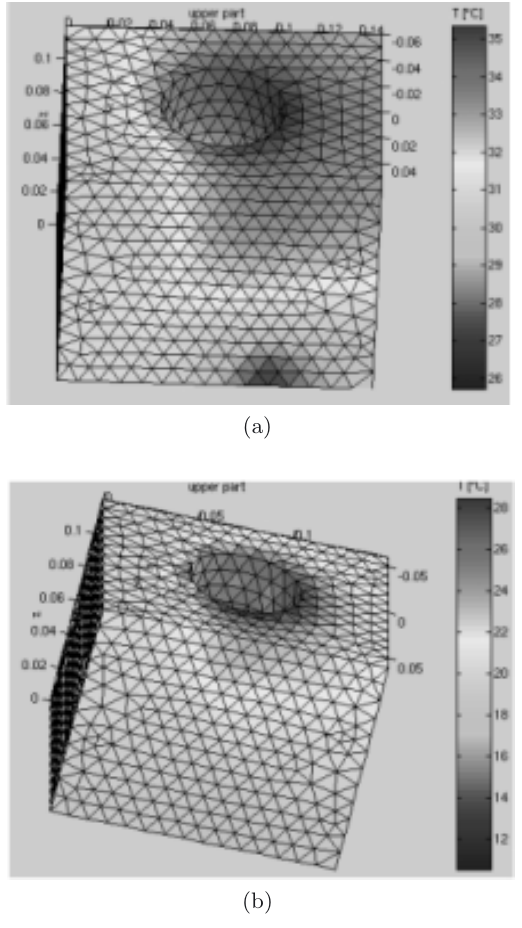
Fig. 16. Temperature at the surface of the 3D mold after